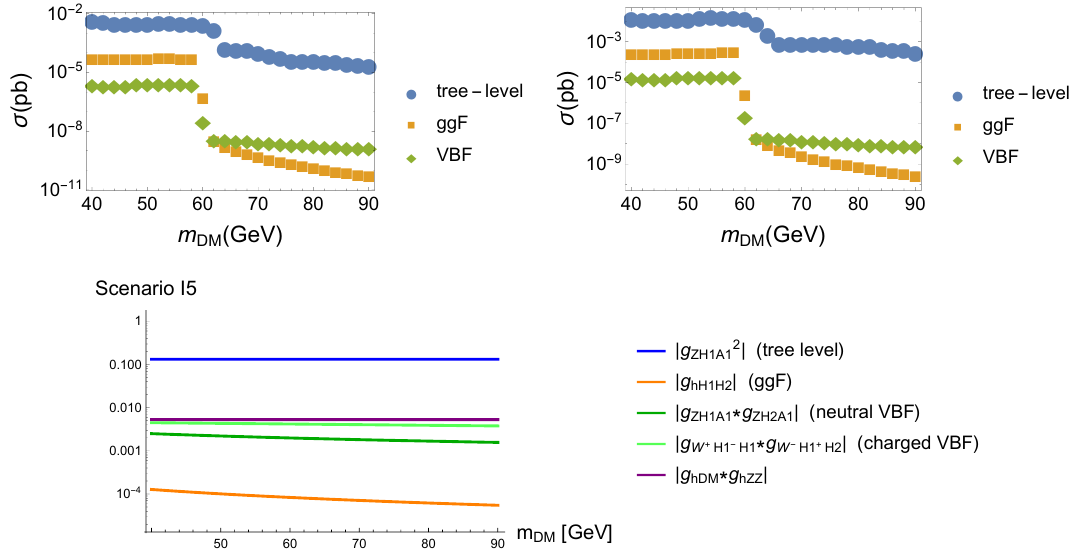
Figure 10 . The anatomy of scenario I5. The plots on the top show the cross sections of the tree- level, ggF and VBF processes with leptonic (left) and hadronic (right) (cid:12)nal states. At the bottom we show the dominant couplings in each process in Log scale with the same color coding where the Higgs-DM coupling is shown for reference. Note that the g hH cross section calculations.